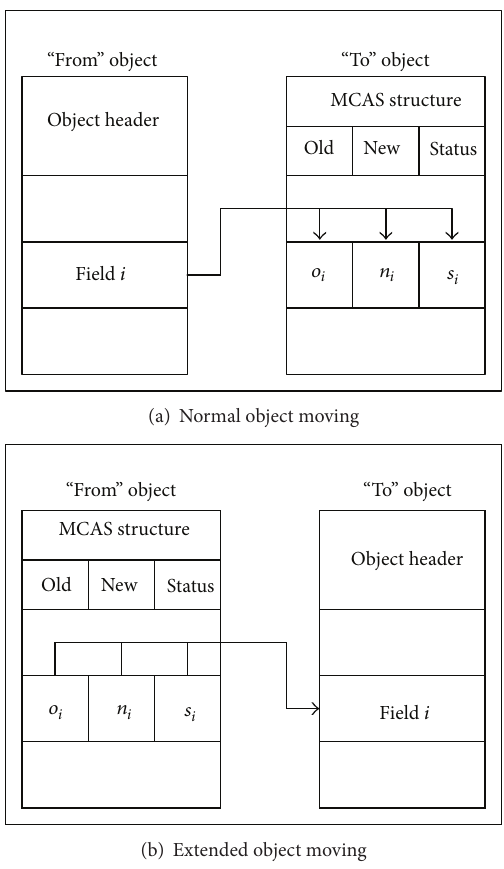
Figure 4: Illustration of asymmetric